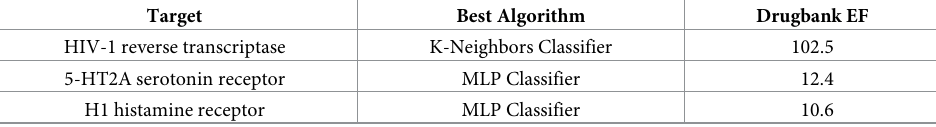
Table 2. Values of enrichment after apply the virtual screening strategy in three different